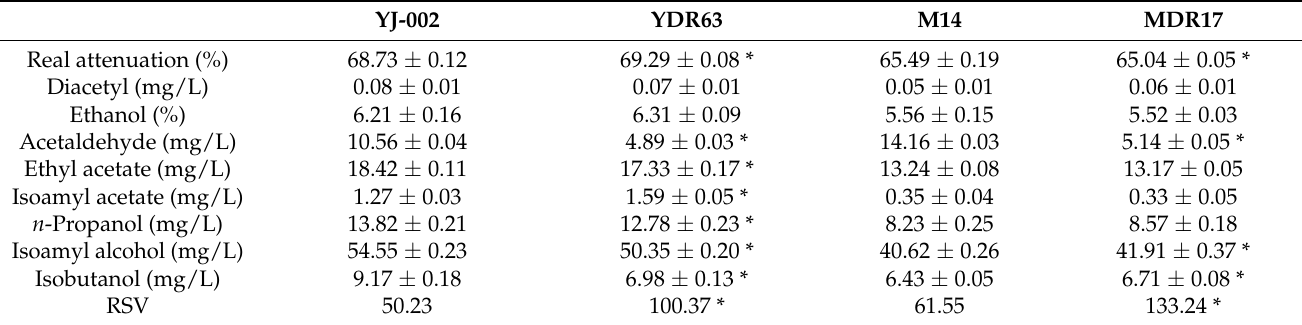
Figure 4. Fermentation performance of the optimal strain YDR-63 and parental strain YJ-002. ( a ) Cell amounts; ( b ) apparent extract; ( c ) diacetyl content; ( d ) ethanol production. Three samples were collected at each time point, and the data are shown as mean ± SD. Table 1. Parameters after the fermentation in CCTs with 14 ◦ P wort (mean ± SD, n = 3, * p <